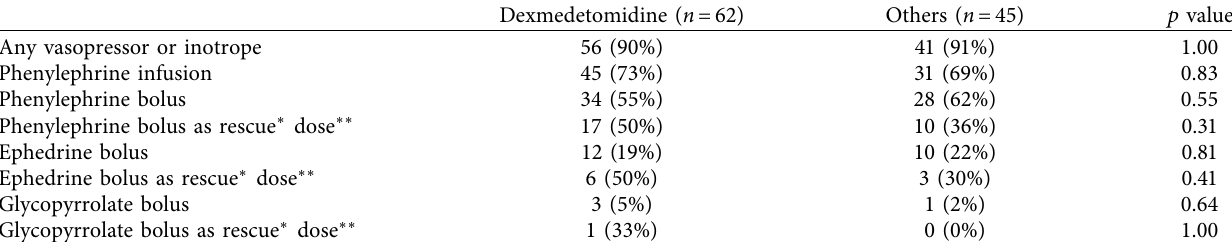
Table 3: Inotrope and vasopressor